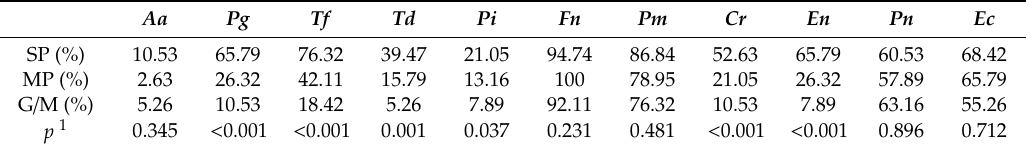
Table 3. Prevalence of target bacteria in gingival retraction cord samples of di ff erent study groups.